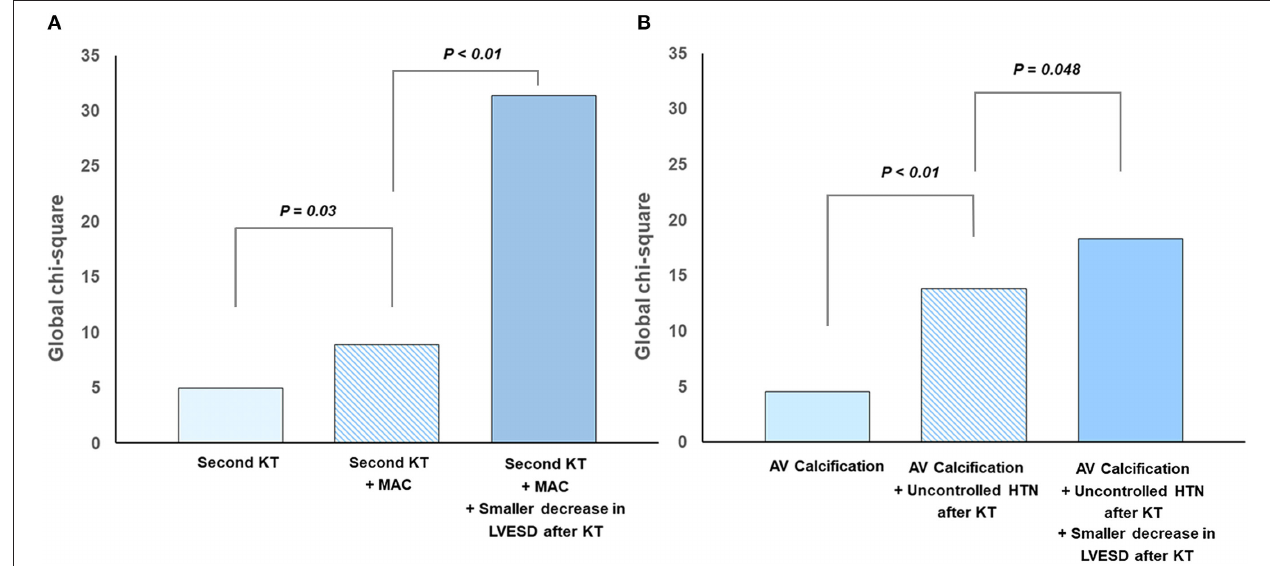
FIGURE 2 | Predictors for progression of left-sided valvular regurgitation after kidney transplantation: (A) mitral regurgitation and (B) aortic regurgitation.